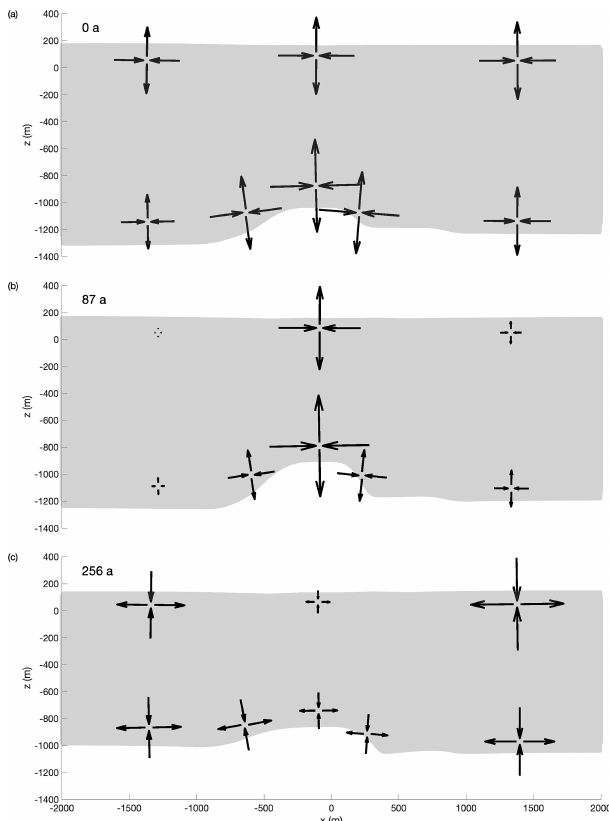
Figure B6. Schematic arrows with their length according to the simulated principal strain magnitude and the pointing direction fitting to principal strain directions at specific points in the cross-section for three different points in time: (a) t = 0 years (after the spin-up, maximum lateral compression), (b) t = 87 years (small lateral displacement) and (c) t = 256 years (end of the